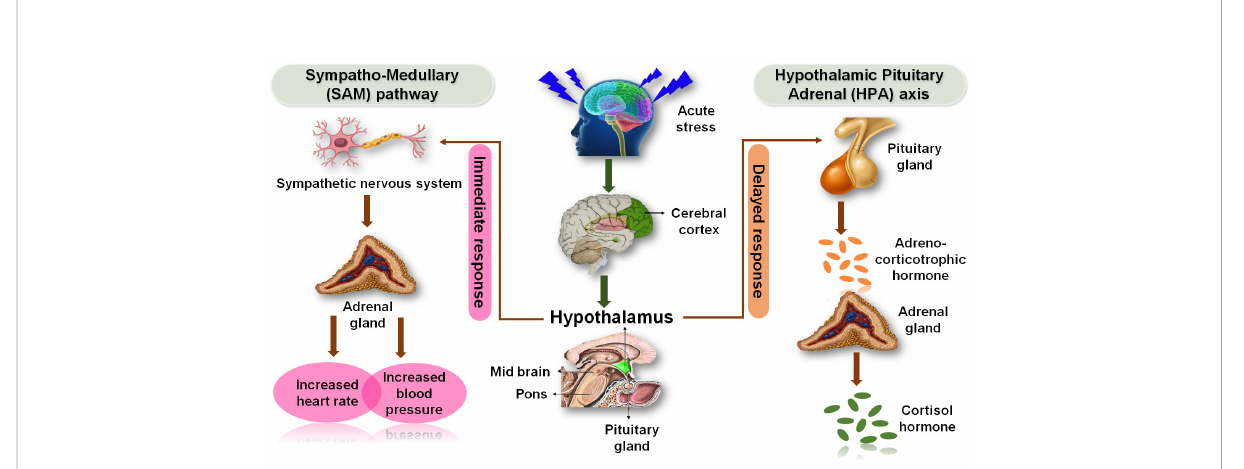
FIGURE 2 Stress responsive pathways of nervous and endocrine systems. Effects of acute stress on the nervous system and endocrine system that are usually mediated through SAM and HPA axis